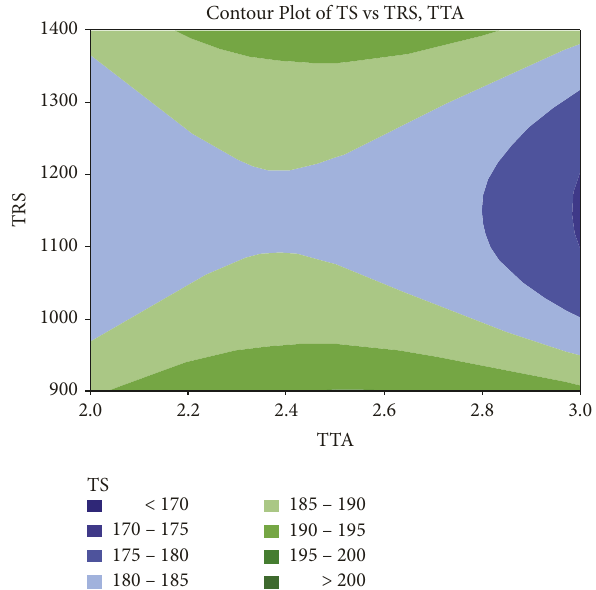
Figure 15: Contour plot TS vs TRS and TTA.